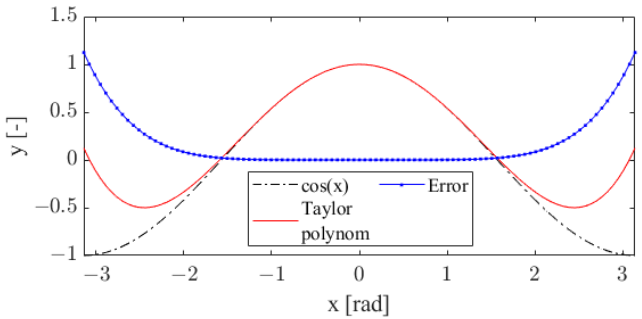
Figure 8. Second-order Taylor approximation of a cosine function.